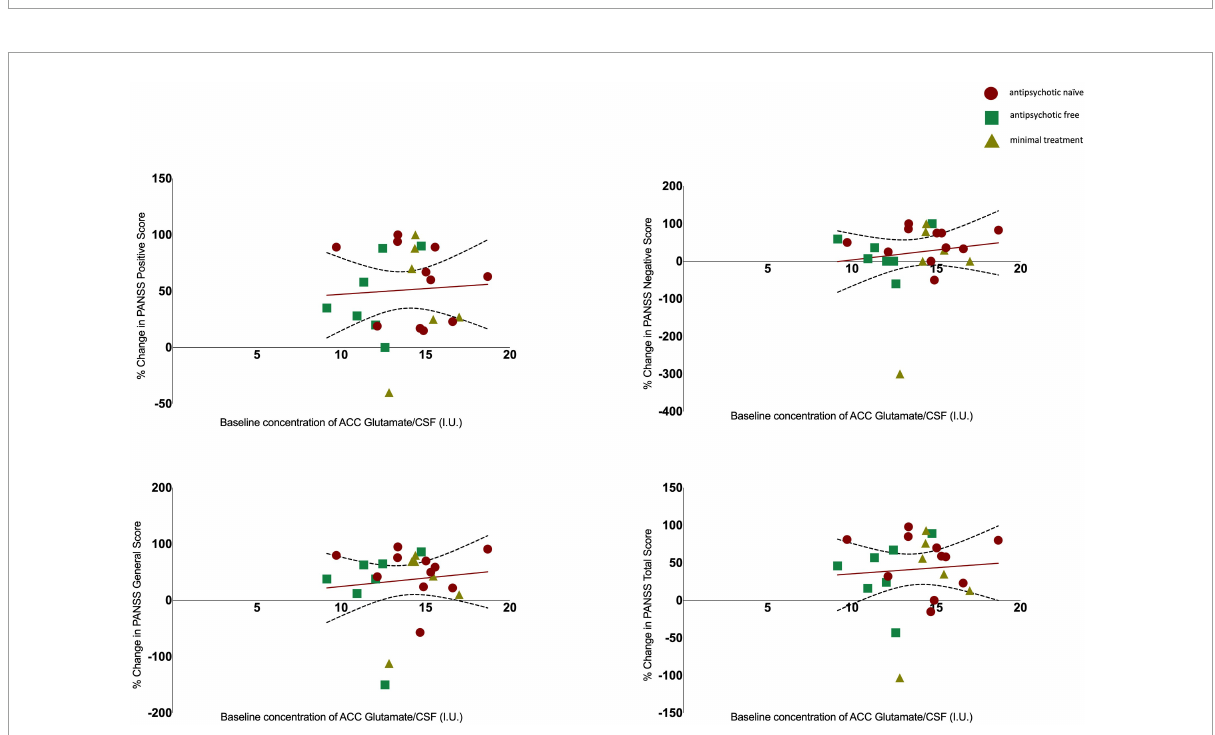
FIGURE2 Relationship between glutamate levels and the percentage change in PANSS positive ( r = 0.061, p = 0.777), negative ( r = 0.144, p = 0.502), general ( r = 0.110, p = 0.607), and total scores ( r = 0.078, p = 0.719), with 95% confidence intervals derived from the line of best fit. Individuals are stratified by medication status, antipsychotic naïve (circle), antipsychotic free (square), minimal treatment